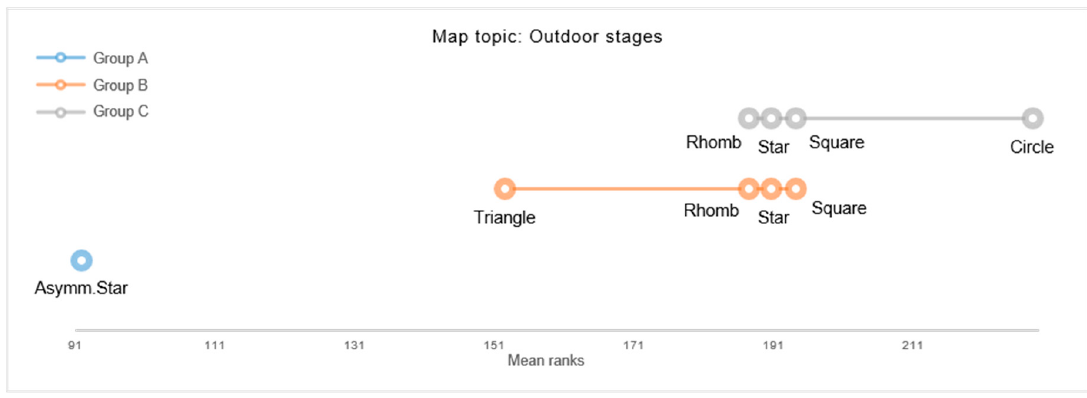
Figure 12. Map #8: Results of multiple pairwise comparisons, indicating groups of (dis)similar symbol-content congruence.